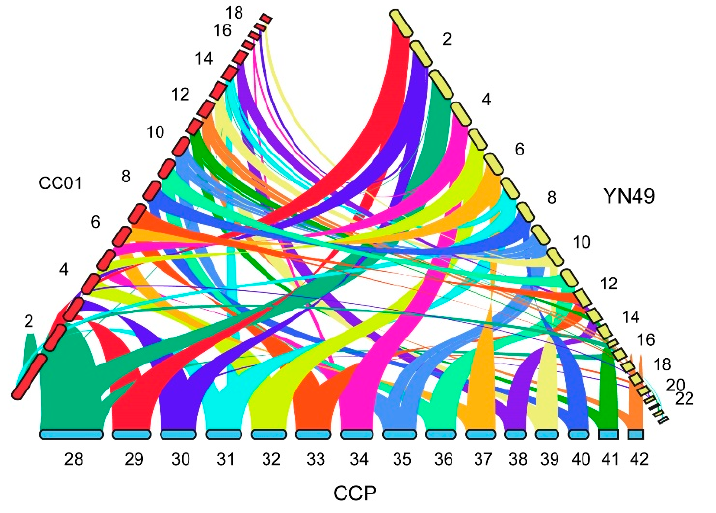
Figure 5. Synteny analysis of C. cassiicola YN49, CC01 and CCP strains. Phylogenomic analysis revealed that C. cassiicola YN49 and CC01 are evolutionarily closely related to C. cassiicola CCP. Therefore, we performed synteny comparison between these three species. The resulting synteny dot-plot shows macrosynteny between the three genomes, and high levels of sequence homology between strains. There are 19 contigs in YN49, 23 contigs in CC01 and 15 contigs in CCP with conserved syntenic blocks.